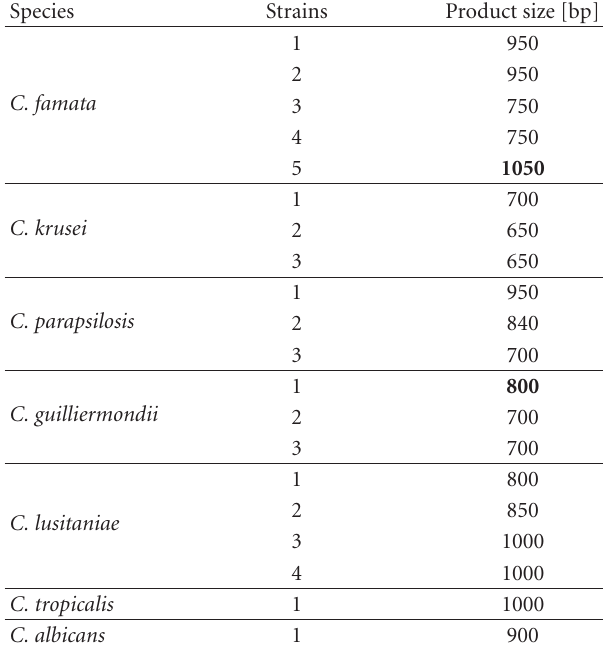
Table 2: PCR products of Candida of genomic DNA generated with the ITS1 and NL2 primers. Black bold type fonts shows Warsaw